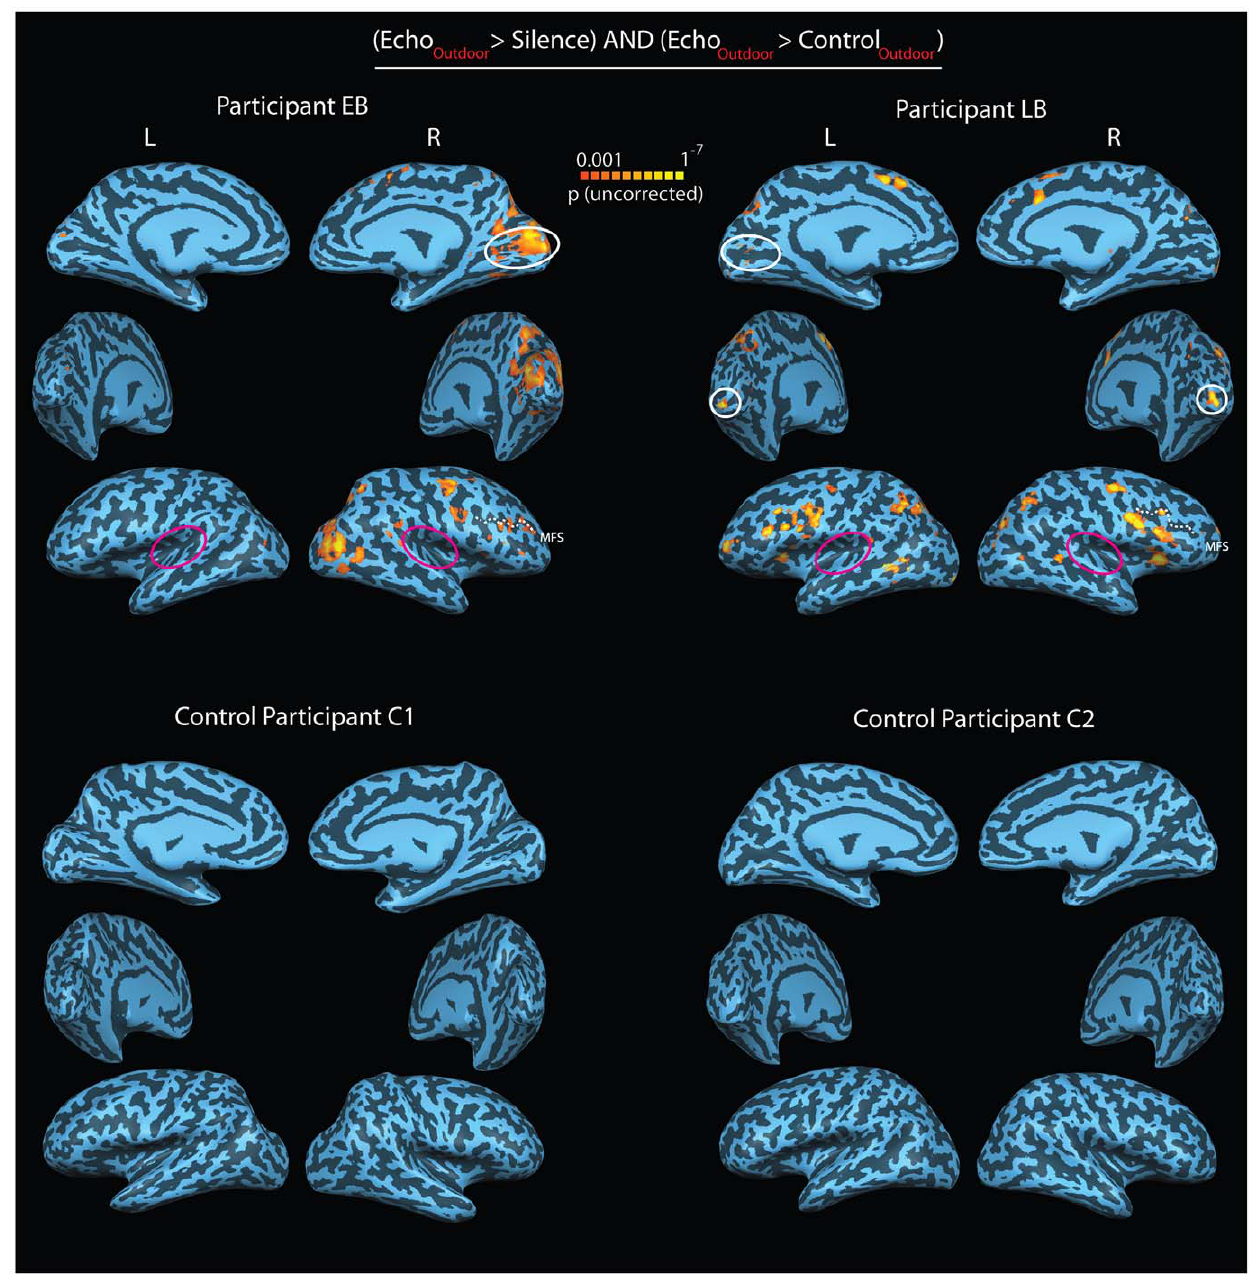
Figure 3. BOLD activity projected on participants reconstructed and partially inflated cortical surface. Marking of cortical surfaces and abbreviations as in Figure 2. Top panel: Contrast between activations for outdoor recordings containing echoes from objects and recordings that did not contain such echoes for EB and LB. During the experiment EB and LB listened to outdoor scene recordings and judged whether the recording contained echoes reflected from a car, tree or pole or no object echoes at all. Each participant listened to recordings of his own clicks and echoes as well as to recordings of the other person (see Figure 1G for behavioral results; for example sounds listen to Sound S12 and Sound S13). Bottom panel: Contrast between activations for outdoor recordings containing echoes from objects and recordings that did not contain such echoes for C1 and C2. The task was the same as for EB and LB and each participant listened to recordings they had trained with as well as to the recordings of the other person, e.g. C1 listened to both EB’s and LB’s recordings (see Figure 1G for behavioral results). It is evident that both EB and LB, but not C1 or C2, show increased BOLD activity in the calcarine sulcus for recordings that contain echoes (highlighted in white). EB mainly shows increased activity in the calcarine sulcus of the right hemisphere, whereas LB shows activity at the apex of the occipital lobes of the right and left hemisphere, as well as in the calcarine sulcus of the left hemisphere. In addition, both EB and LB, but not C1 or C2, show an increase in BOLD activity in along the medial frontal sulcus. This result most likely reflects the involvement of higher order cognitive and executive control processes during echolocation. There is no difference in BOLD activity along the lateral sulcus for any participant, i.e. Auditory Complex (highlighted in magenta). This result was expected because the Echo stimuli and the Control stimuli had been designed in a way that minimized any spectral, temporal or intensity differences. No BOLD activity differences were found when activations for EB’s recordings were contrasted with activations for LB’s recordings.